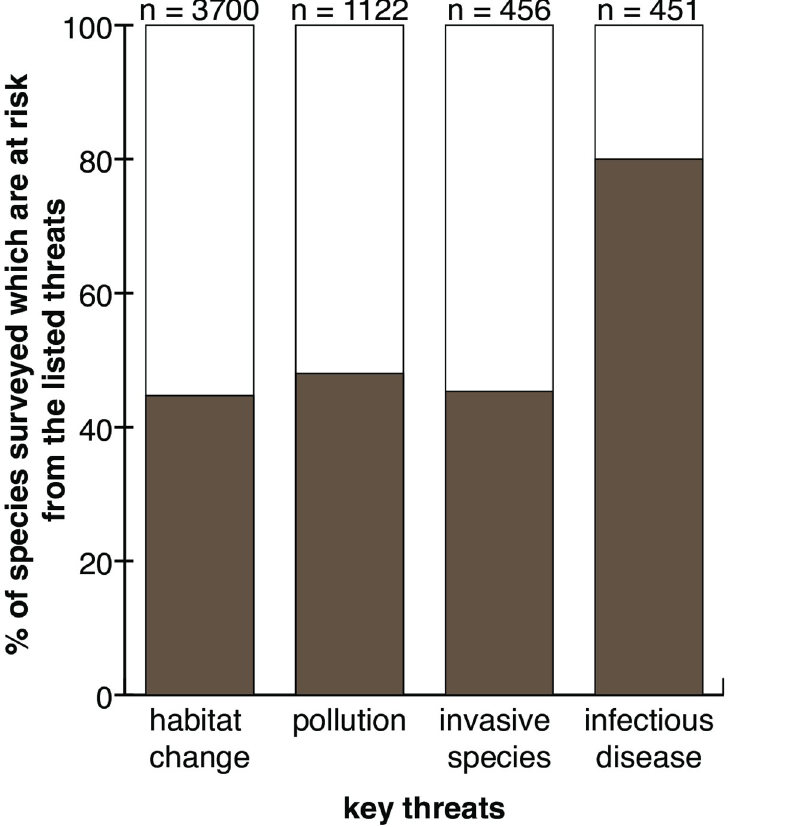
Fig 1. Graph illustrating key threats to amphibians. Adapted from Chanson and colleagues (2008) [2].